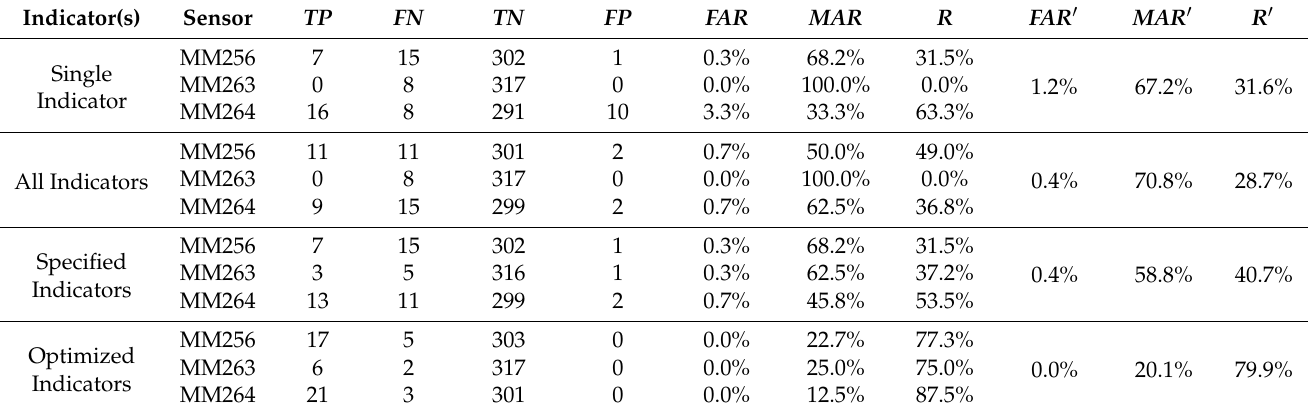
Table 3. The evaluation of gas abnormal or normal emission prediction results by different indicators